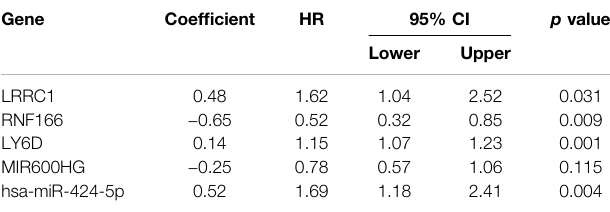
TABLE 3 | Multivariate Cox proportional hazards regression model including the key members of the ceRNA network for overall survival in patients with PAAD. Gene Coef fi cient HR 95% CI p value Lower Upper LRRC1 0.48